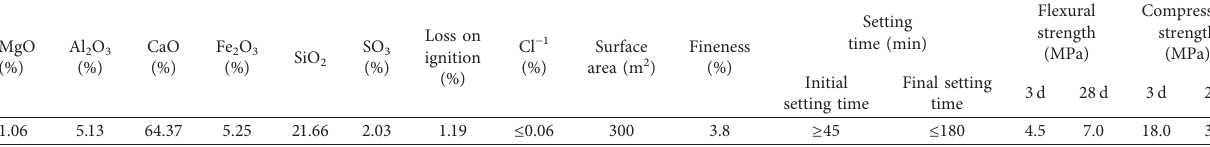
Table 1: Properties and chemical composition of ordinary Portland cement.